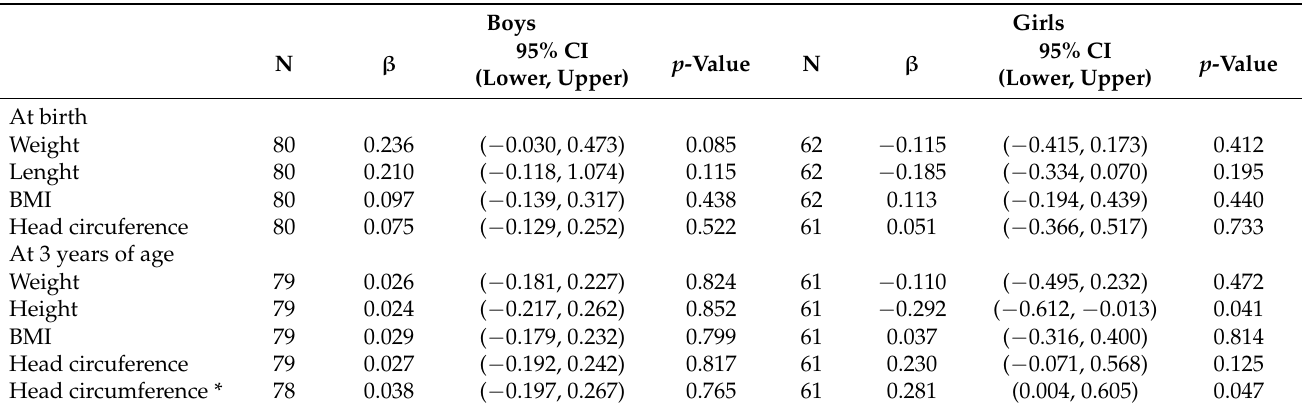
Table 5. Associations between the face fixation duration (%) and standardized body size indices (Z-scores) after adjusting for